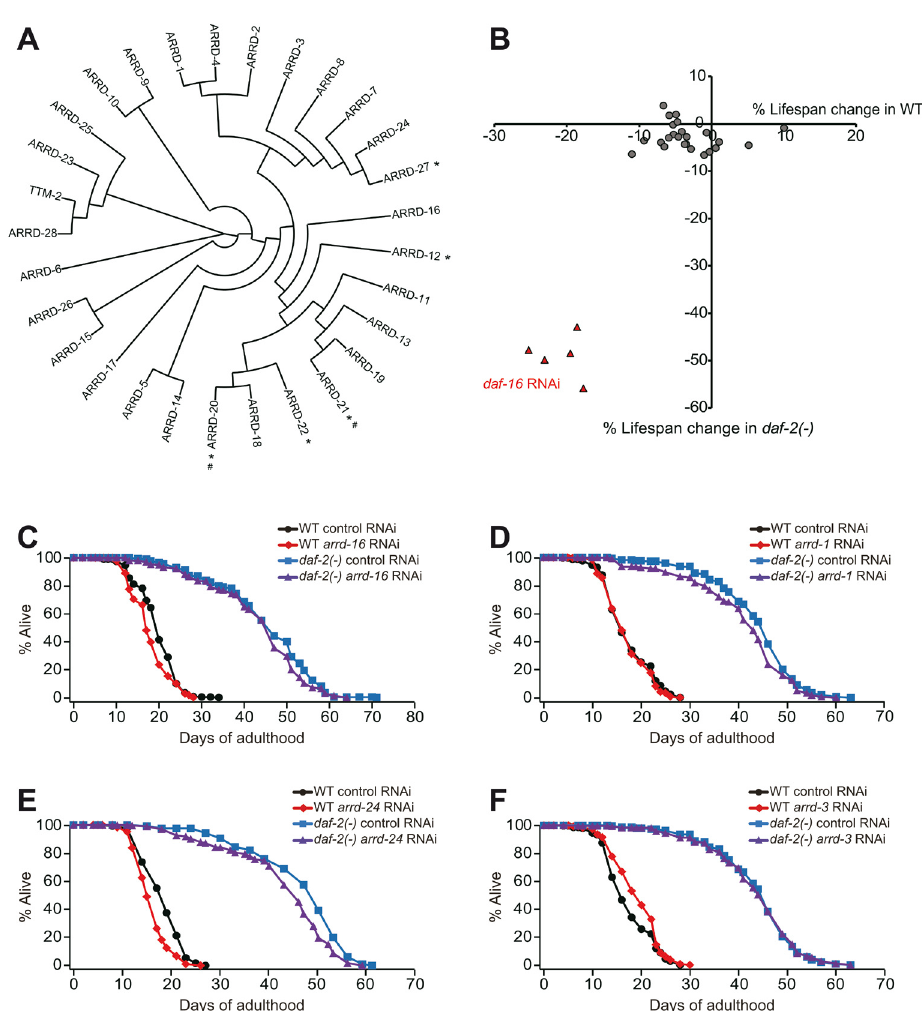
Figure 1. Feeding bacteria expressing dsRNA targeting each of Caenorhabditis elegans α -arrestins had little effect on lifespan. ( A ) A phylogenetic tree showing C. elegans α -arrestin family members. Asterisks (*) indicate α -arrestins that were not examined in this study and number signs (#) indicate predicted pseudogenes. ( B ) Each circle represents percent mean lifespan change by feeding wild-type (WT) and daf-2(e1370) ( daf-2(-) ) mutants with bacteria expressing dsRNA against each of α -arrestin genes. Red triangles indicate lifespan changes by daf-16 RNAi bacteria feeding, which was used as a positive control. ( C – F ) Lifespan curves of WT and daf-2(-) animals fed with dsRNA-expressing bacteria targeting arrd-16 ( C ), arrd-1 ( D ), arrd- 24 ( E ), and arrd-3 ( F ). See Table S2 for statistical analysis.